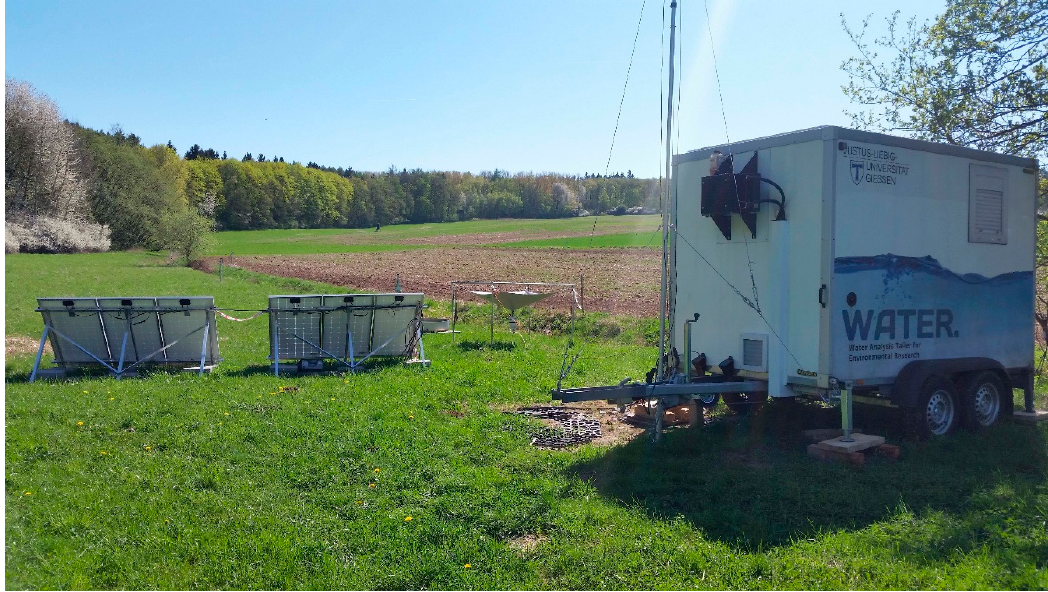
Figure 2. Water Analysis Trailer for Environmental Research (WATER) ( right ), two solar panels supporting power supply ( left ) and the funnel-type tarp for collection of precipitation (further back in the middle) installed in the Schwingbach Environmental Observatory (SEO), Hesse (Germany).